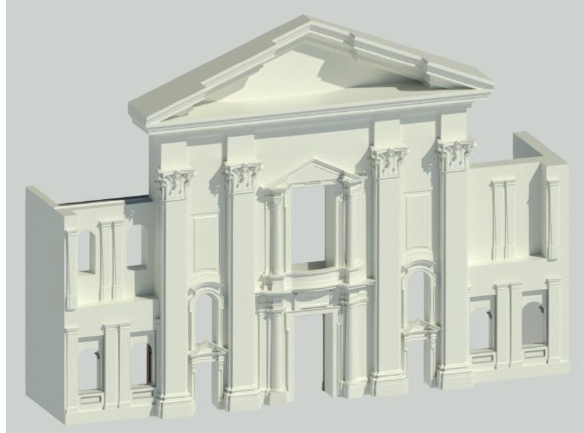
Figure 7. Rendering of the final fac¸ade model, from Autodesk Revit.